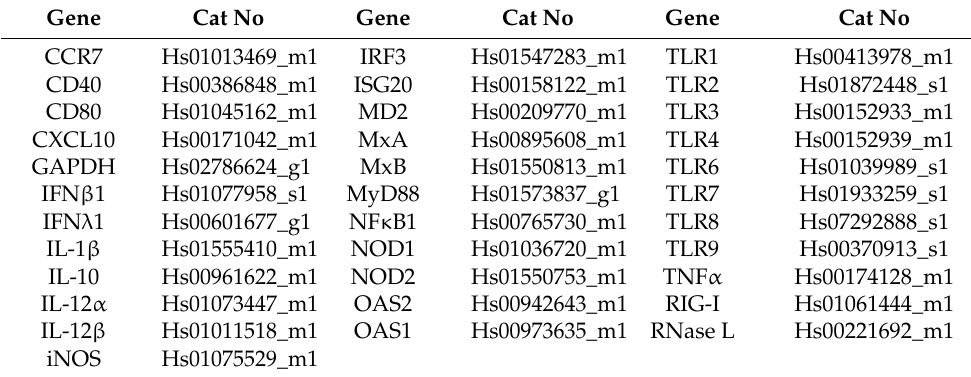
Table 1. TaqMan gene expression assays used in this